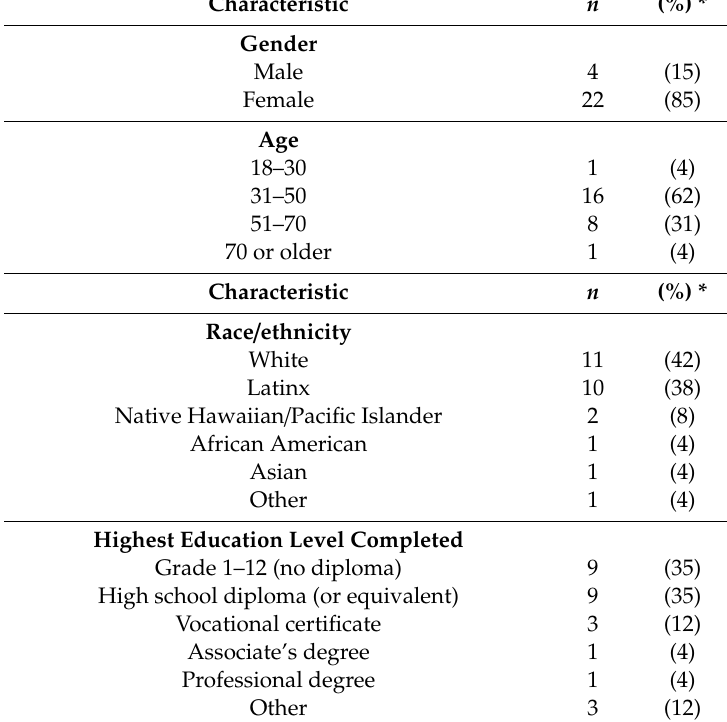
Table 3. Demographic Characteristics of Focus Group Participants. Characteristics of SNAP participants in California participating in focus groups to understand their experiences of the 2019 SNAP benefit disruption ( n =